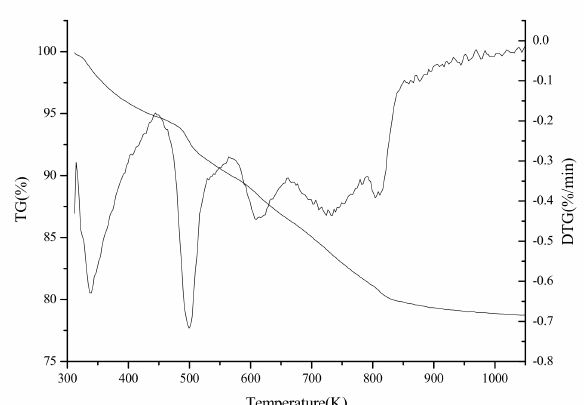
Figure 6. TG-DTG curve of as-synthesized zirconia.